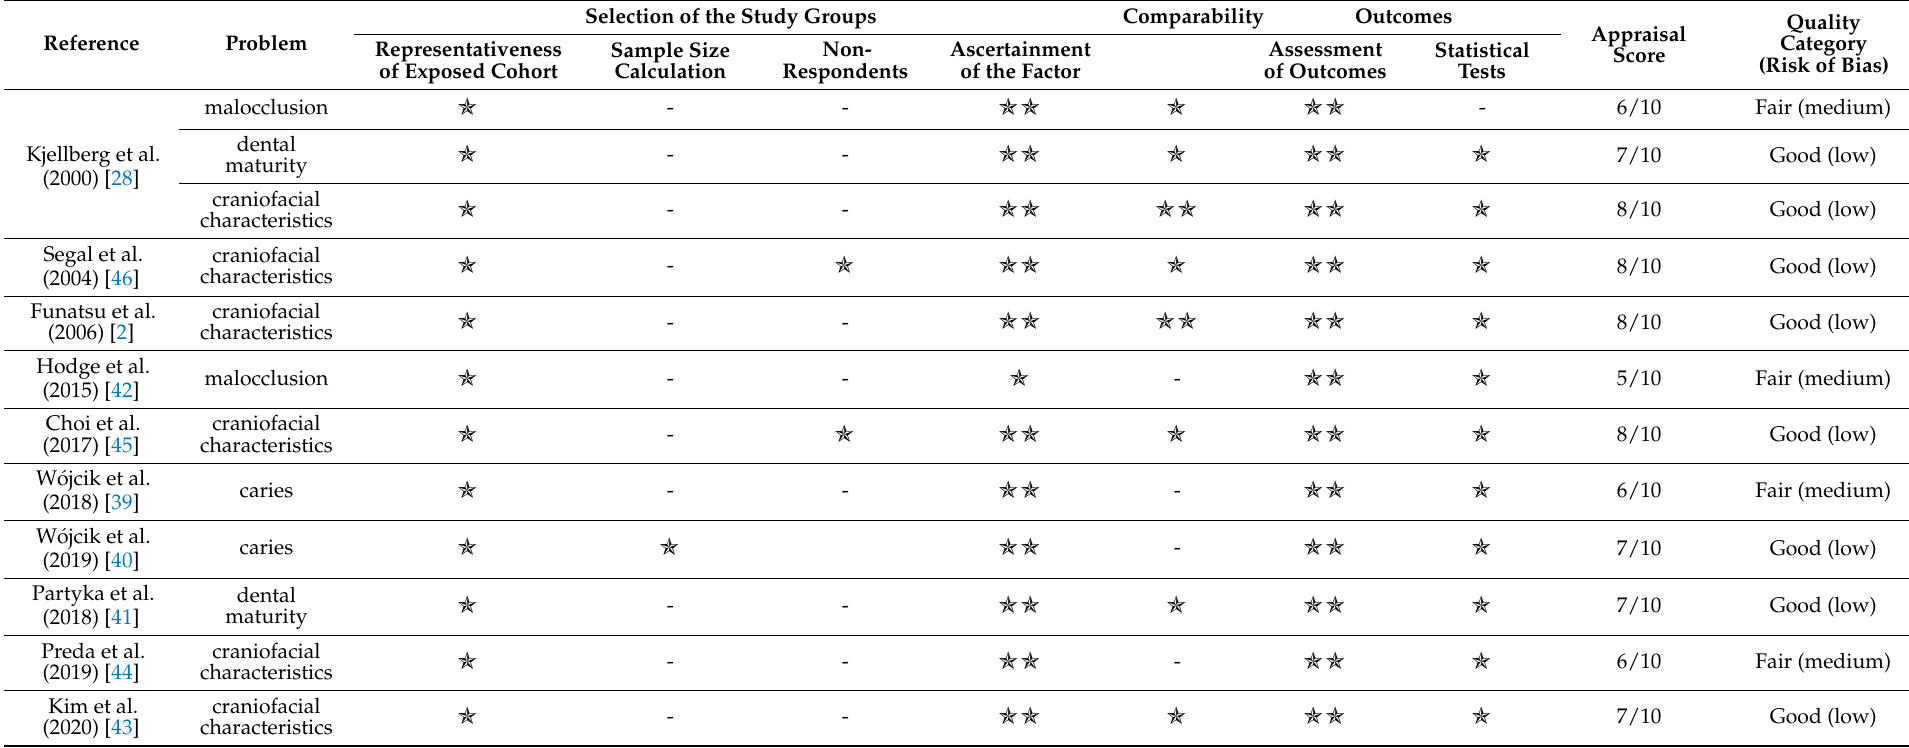
Table 5. Quality assessment of studies using the Newcastle – Ottawa Scale ( ✯ - star (point) awarded in the quality assessment).